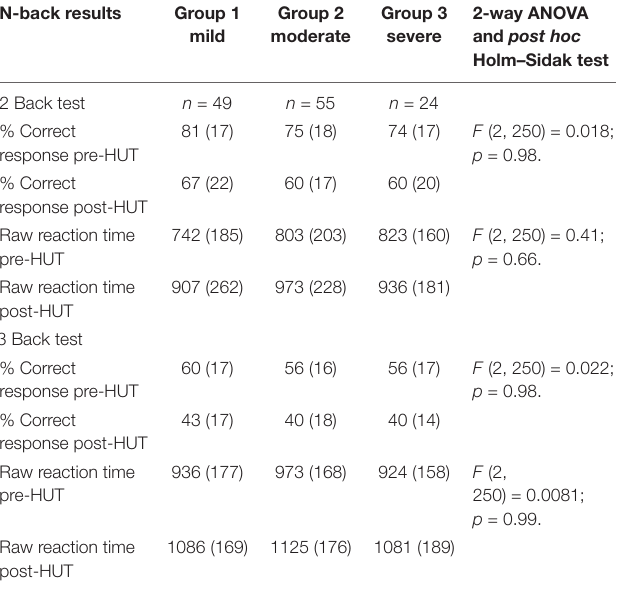
TABLE 4 | N-back results pre- and post-HUT in ME/CFS patients with a mild, a moderate or a severe degree of ME/CFS. N-back results Group 1